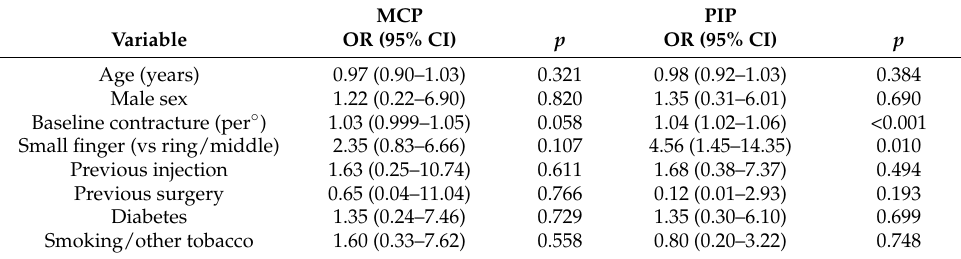
Table 3. Risk factors of recurrence at 5 years; repeat injections were considered as recurrence.